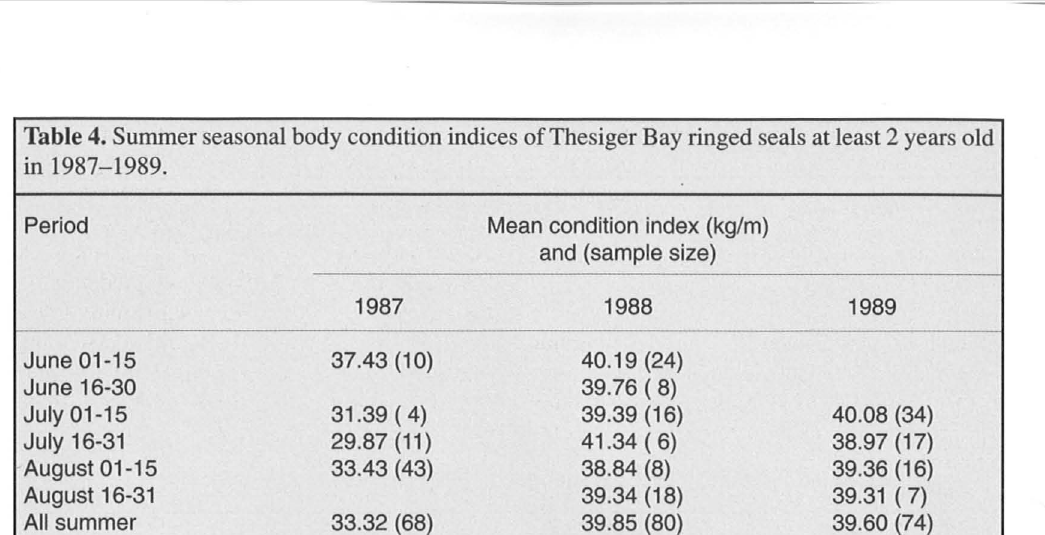
Table 4. Summer seasonal body condition indices of Thesiger Bay ringed seals at least 2 years old in